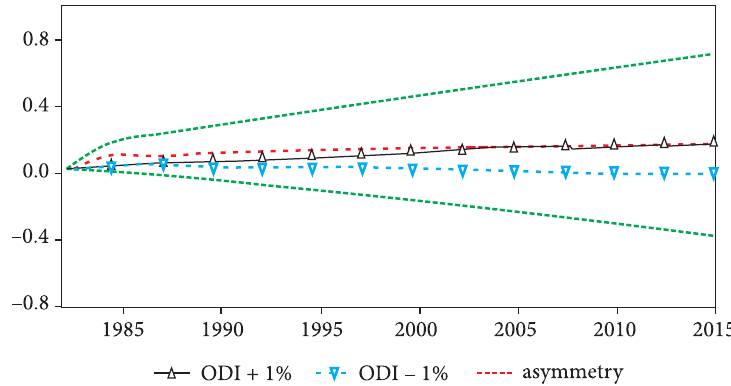
Figure 3. Cumulative asymmetric adjustments of GDP per capita to